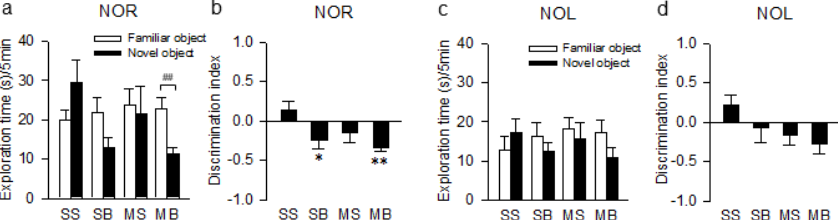
Figure 2. Exploration time and the discrimination index in the novel object recognition test ( a , b )